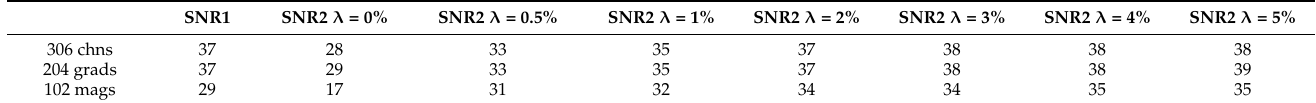
Table 1. SNR values (dB) among sensors (SNR1) and source montage channels (SNR2) in Simulation 1. These values are averages of the highest SNRs for the 29 sources at the source montage locations.